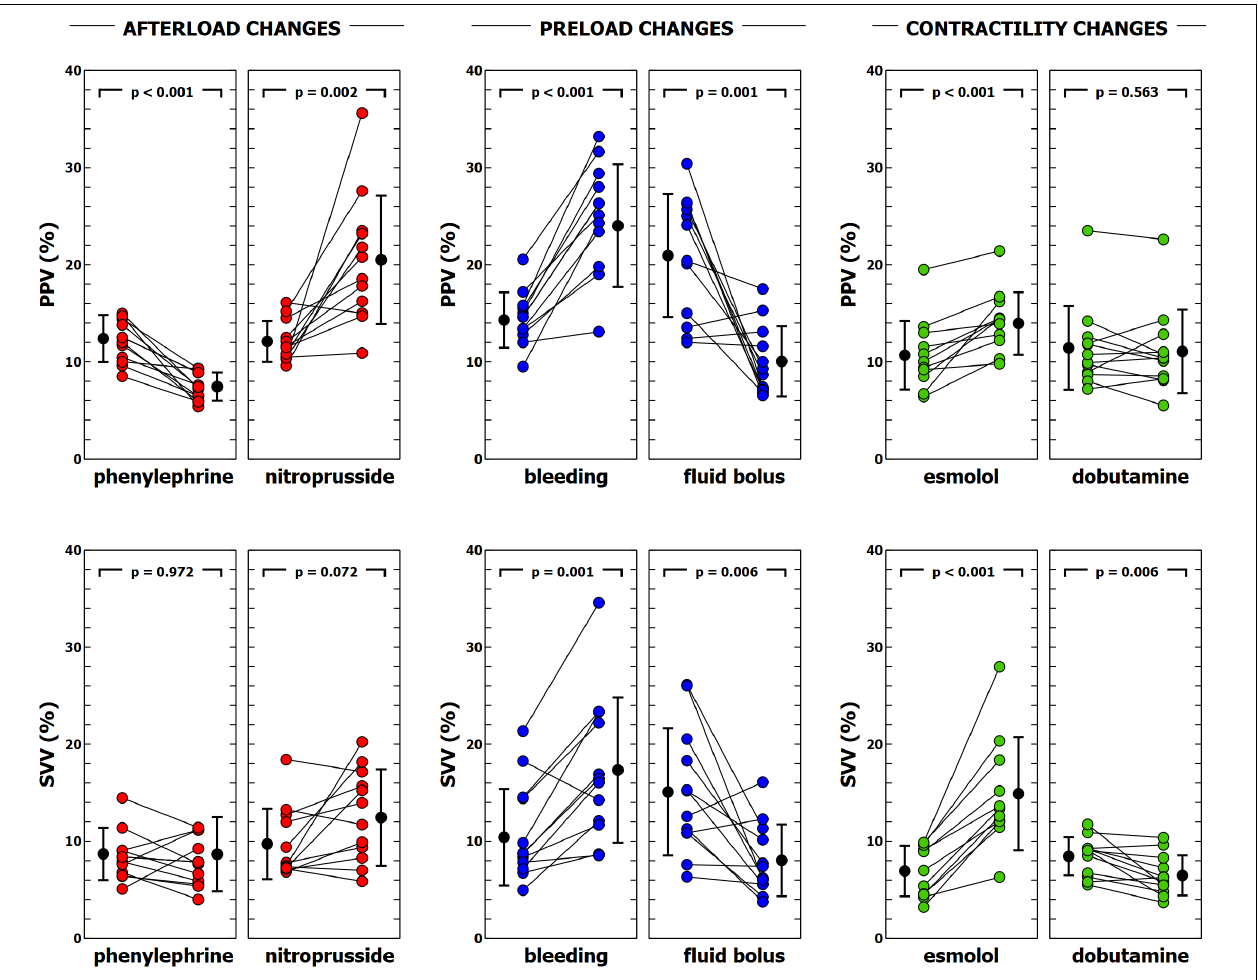
FIGURE 4 | Evolution of pulse pressure variation (PPV) and stroke volume variation (SVV) during different experimental interventions. Individual values of PPV and SVV during each experimental condition. Black points with bars represent the mean value and the standard deviation. Colored points represent individual changes for each